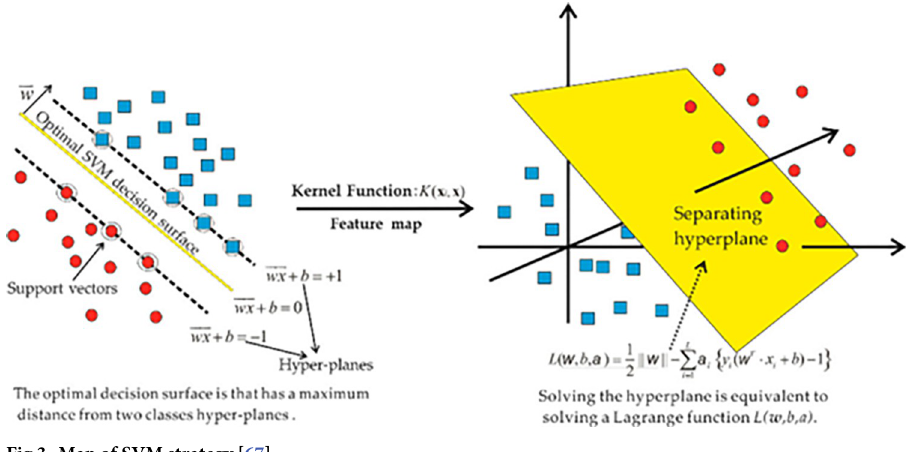
Fig 3. Map of SVM strategy